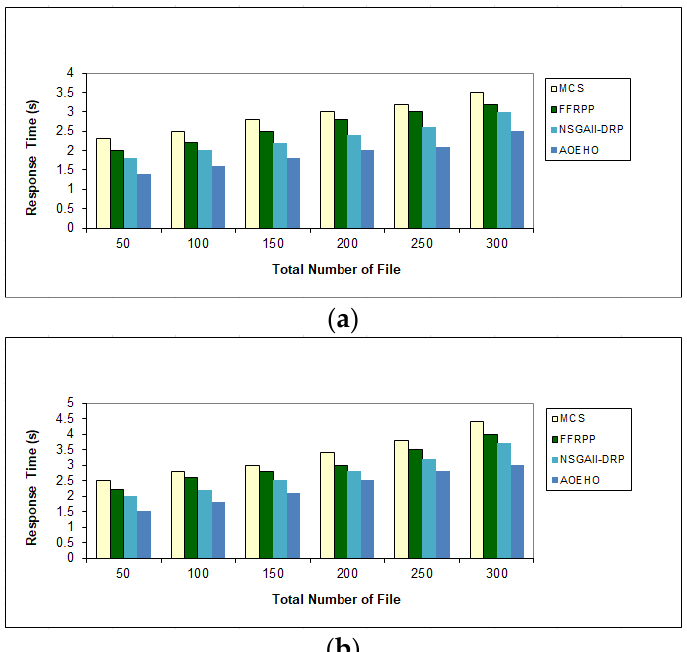
Figure 6. Response time of data file. ( a ) Size of data replication = 320 MB. ( b ) Size of data replication = 320